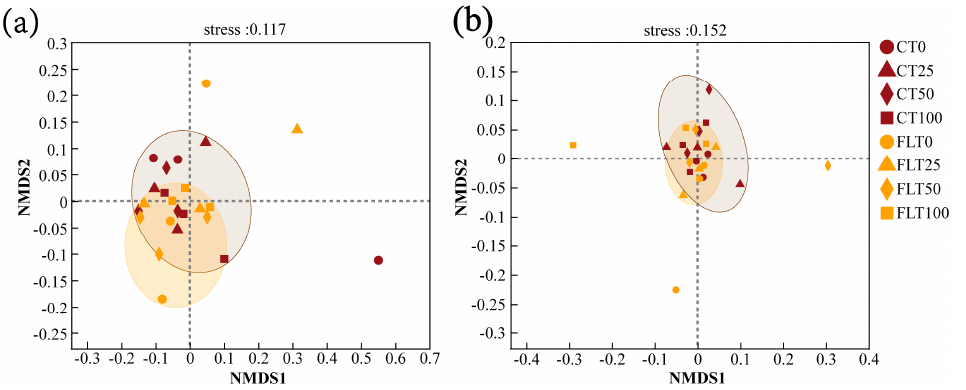
Figure 5. Biplot ordination of non-metric multidimensional scaling (NMDS) of cassava rhizosphere soil fungal communities at OUT level based on Bray–Curtis distance (( a ), 2019; ( b ), 2020).